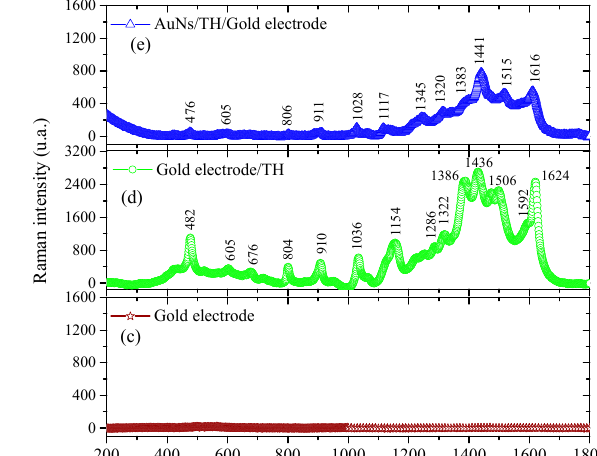
Table 1. Raman bands of a TH solution on carbon or gold substrate assigning its presence and TH solid.